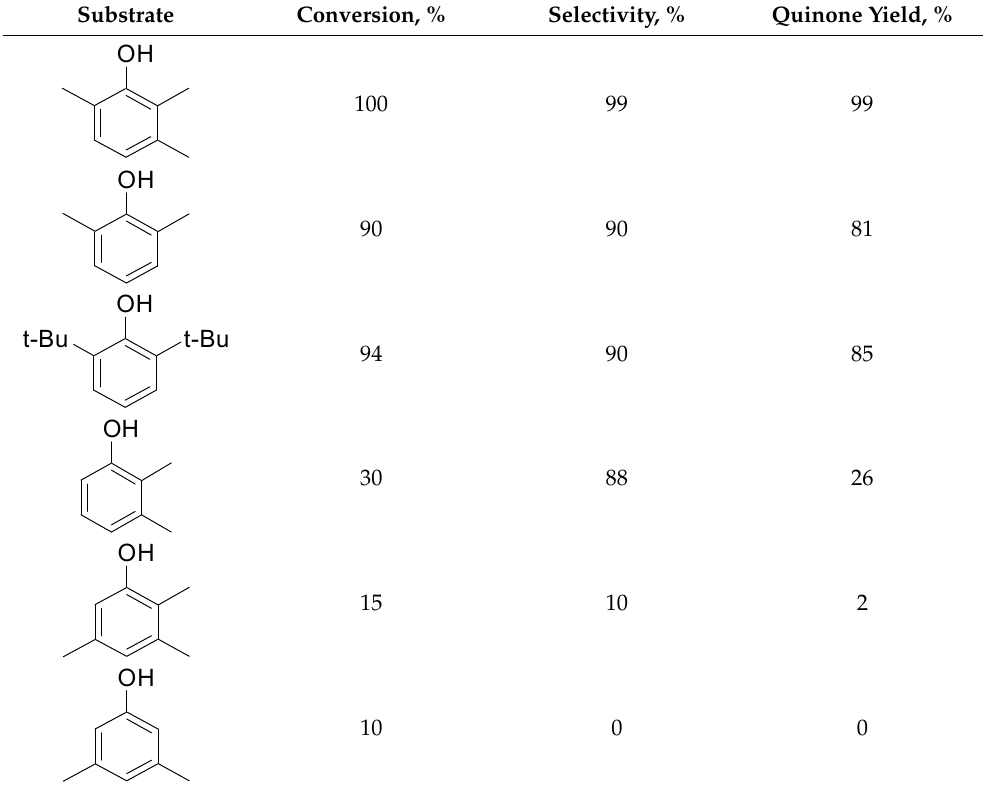
Table 6. Oxidation of various alkylphenols with H 2 O 2 catalyzed by 15 wt. % PV 2 W 10 /N-CNTs (1.8 at. % N). Adapted with permission from ref. [100] Evtushok et al. Highly efficient catalysts based on divanadium-substituted polyoxometalate and N-doped carbon nanotubes for selective oxidation of alkylphenols ACS Catalysis 2018 , 8 , 1297–1307. Copyright 2018 American Chemical Society. Substrate Conversion, % Selectivity, %